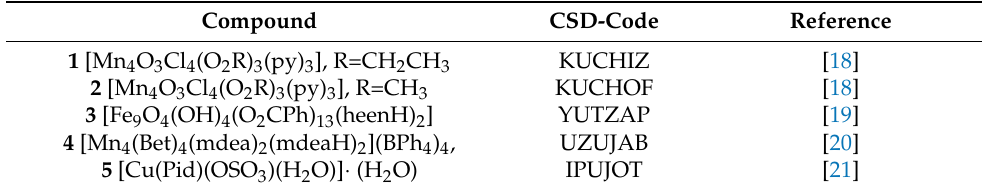
Table 1. Studied